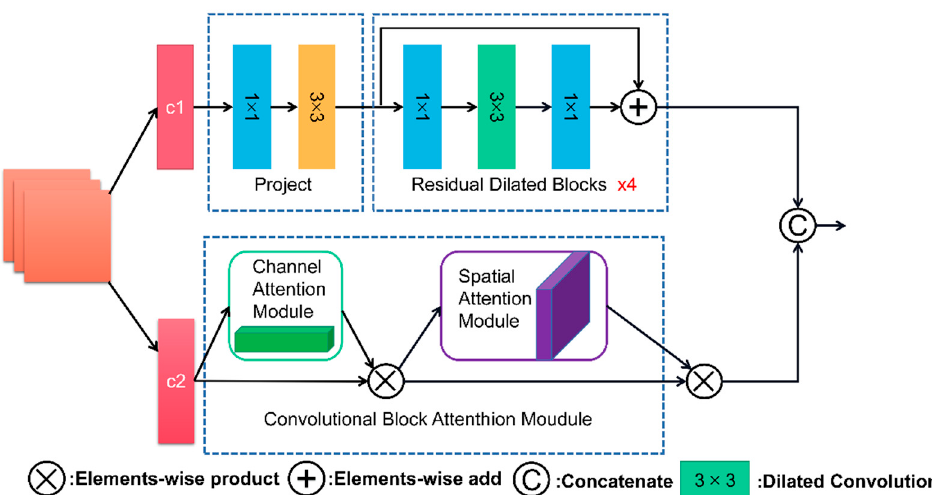
Figure 2. An illustration of the structure of CSPD Block. The features will be split into c1 and c2 in the channel dimension. Firstly, the feature represented by c1 will be passed into the Residual Dilated Block through the project layer to obtain a larger receptive field. Secondly, the feature represented by c2 will be used for calculating attention in the channel dimension and the spatial dimension, respectively, to focus on important information. Finally, the output features of the two parts are concatenated.